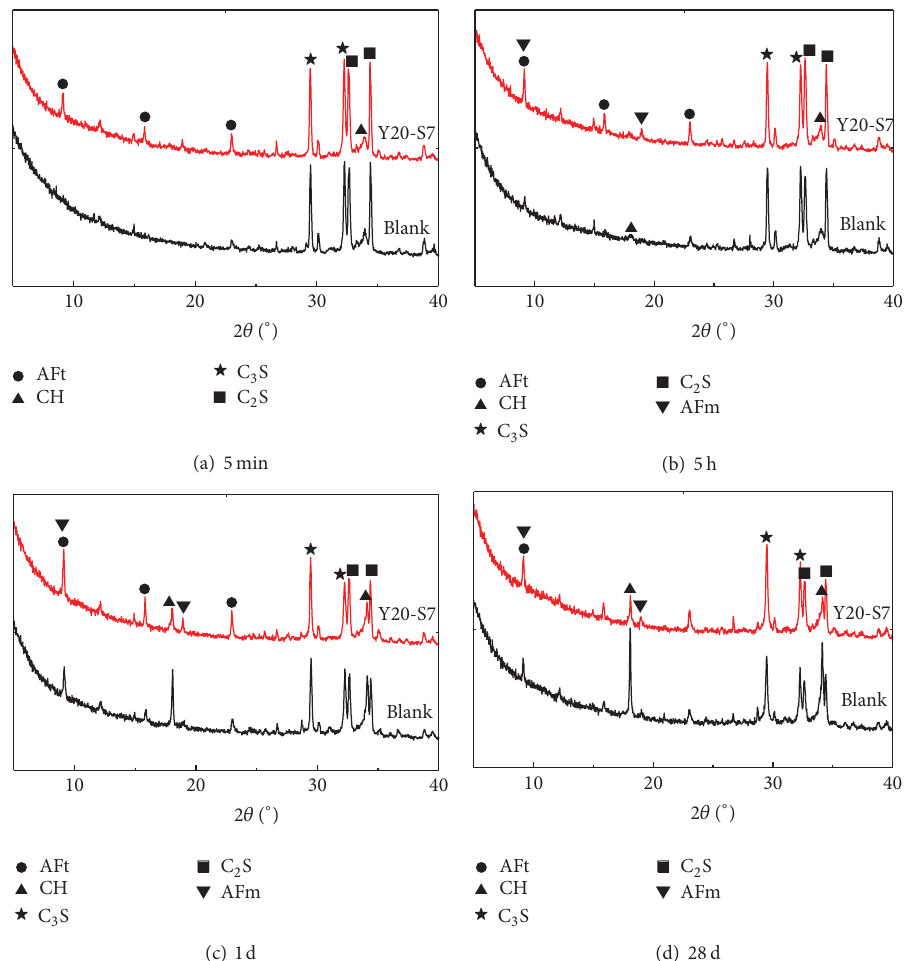
Figure 3: XRD patterns of hydrated cement in addition to 7%